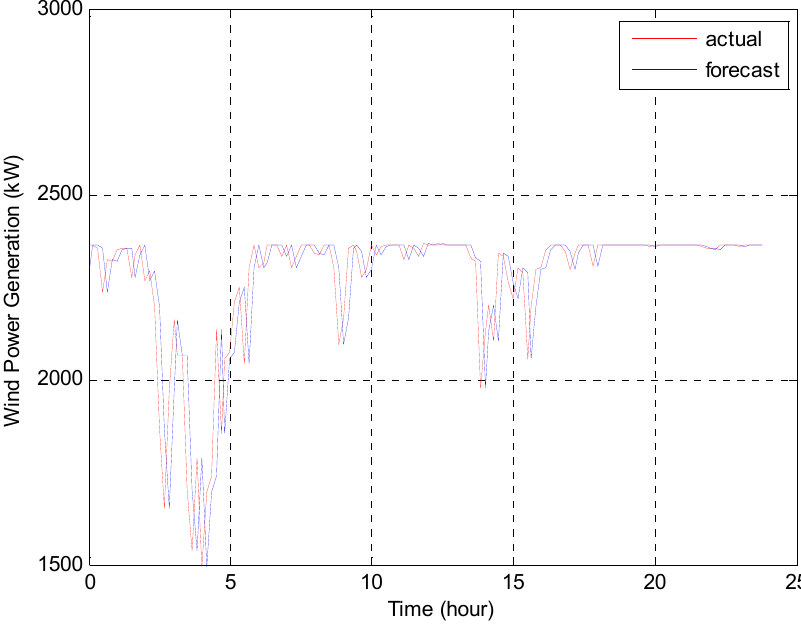
Figure 5. Numerical results with the persistence method for typical winter